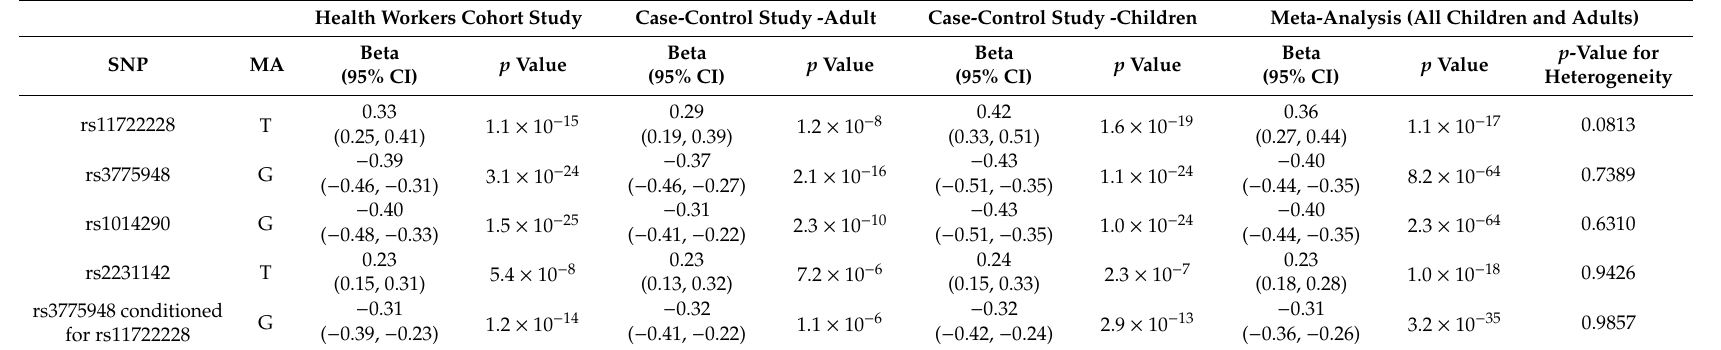
Table 3. Association between SLC2A9 and ABCG2 genes with serum uric acid